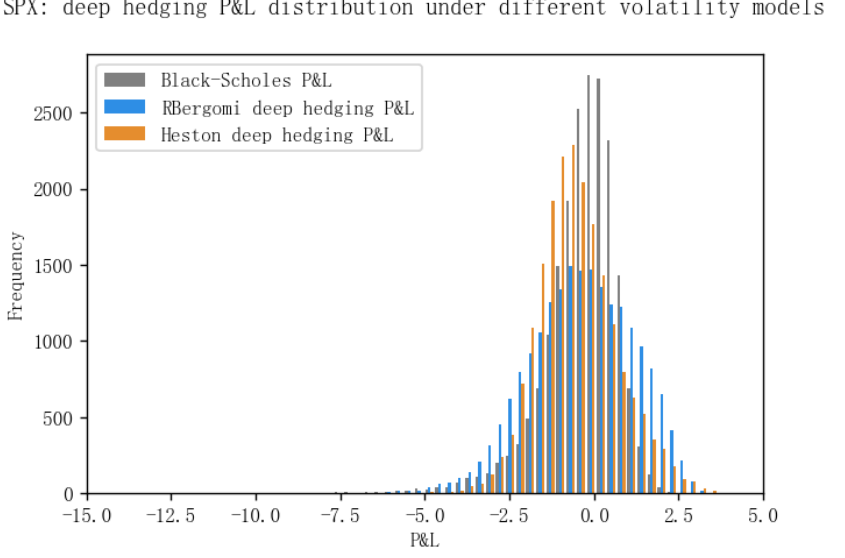
Figure 11. P&L distribution for the S&P options data with maturities from 31 December 2021 to 15 December 2023.